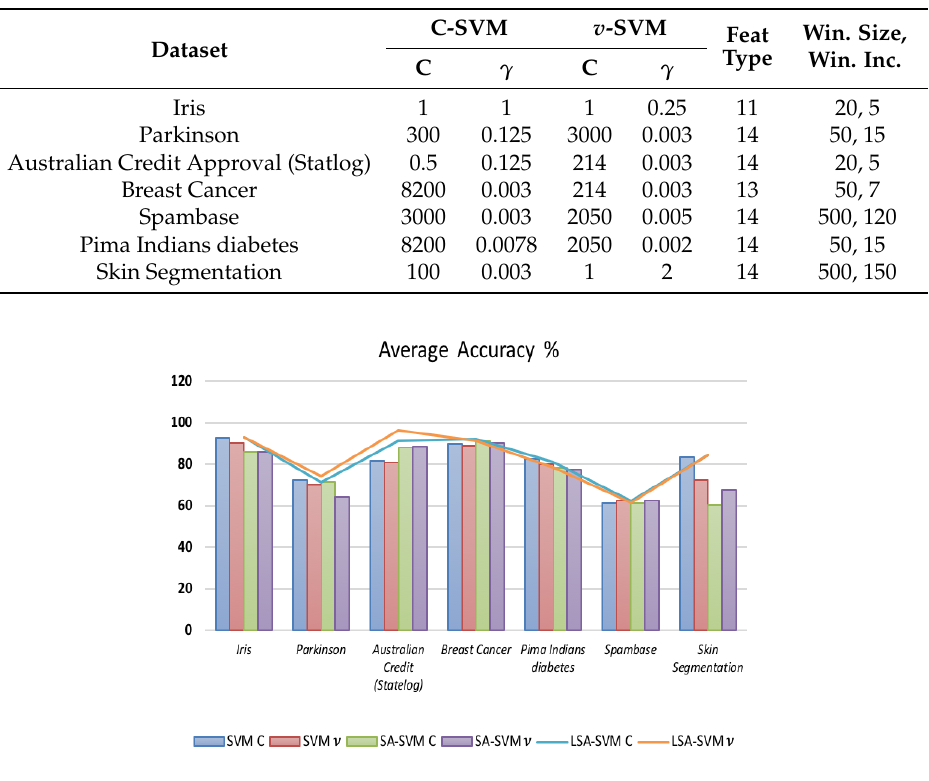
Table 7. The optimal parameters used by each classifier in the UCI [19] dataset experiments for 2-classes.